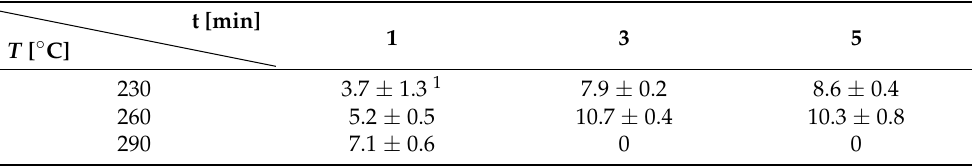
Table 1. Lap shear strength values according to the test plan based on varying the processing conditions of the adhesive agent (at least five specimens per condition were tested).